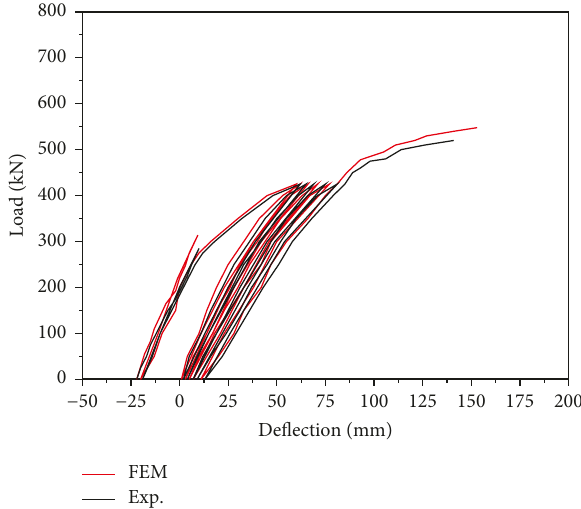
Figure 22: Comparison of FEM and experimental load–net de- flection curves for girder G2.